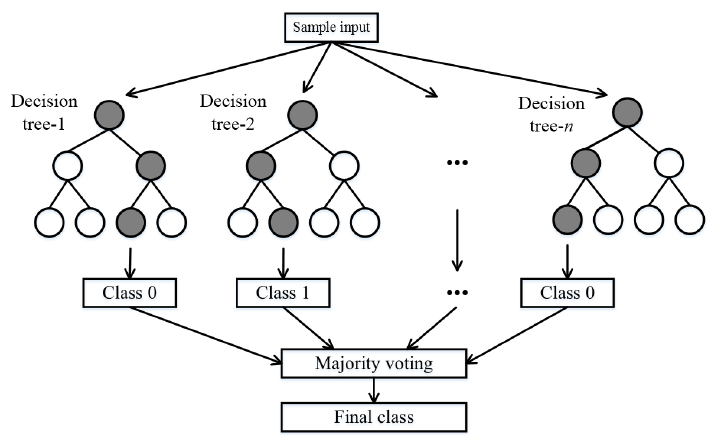
Figure 3. The structure of a bagged tree model. An illustration of how the final prediction for a sample input is generated by such a model, which is composed of multiple decision trees, each trained on a random subset of